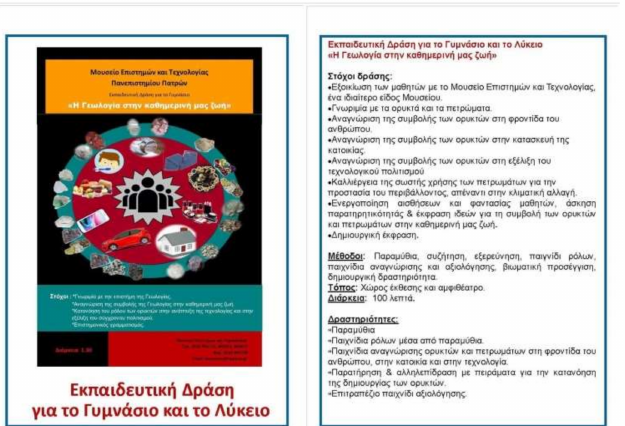
Figure 3. The informational leaflet circulated to school teachers for the Educational Programme “Geology in everyday